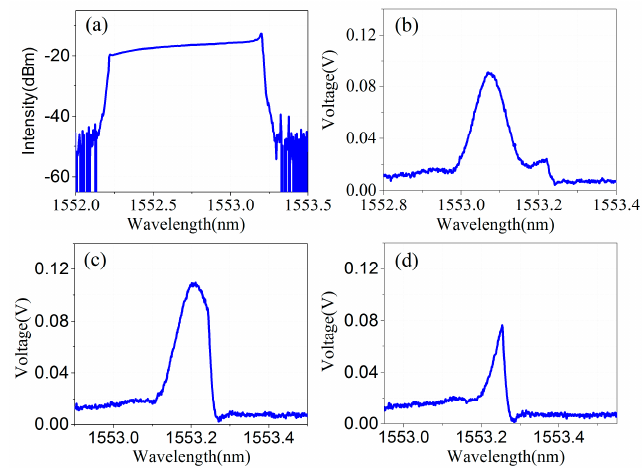
Figure 4. Three types of reflected waveforms of FBG: ( a ) Scanning spectrum of the DFB laser; ( b ) Complete waveform; ( c ) Incomplete waveform type I; ( d ) Incomplete waveform type II.